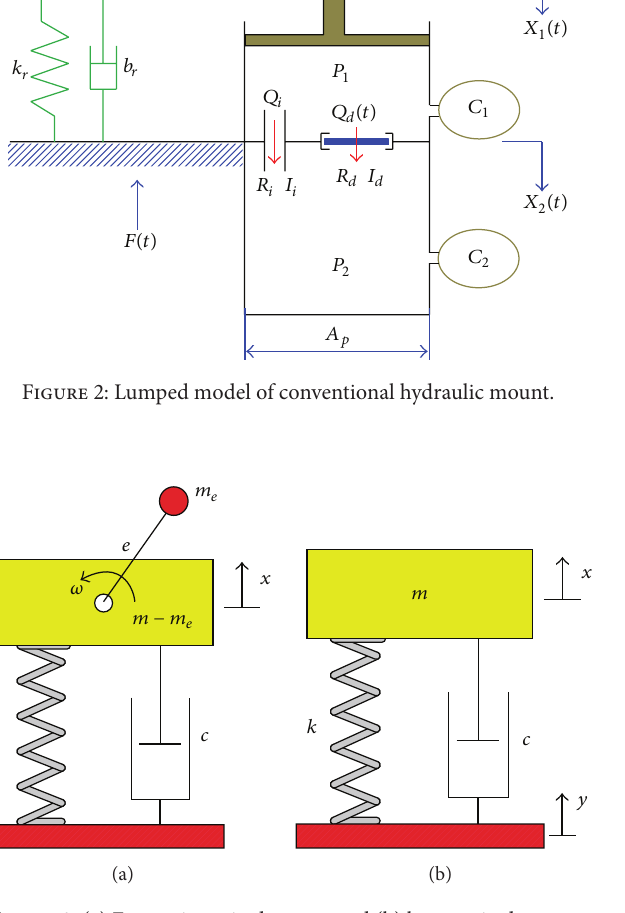
Figure 3: (a) Eccentric excited system and (b) base excited